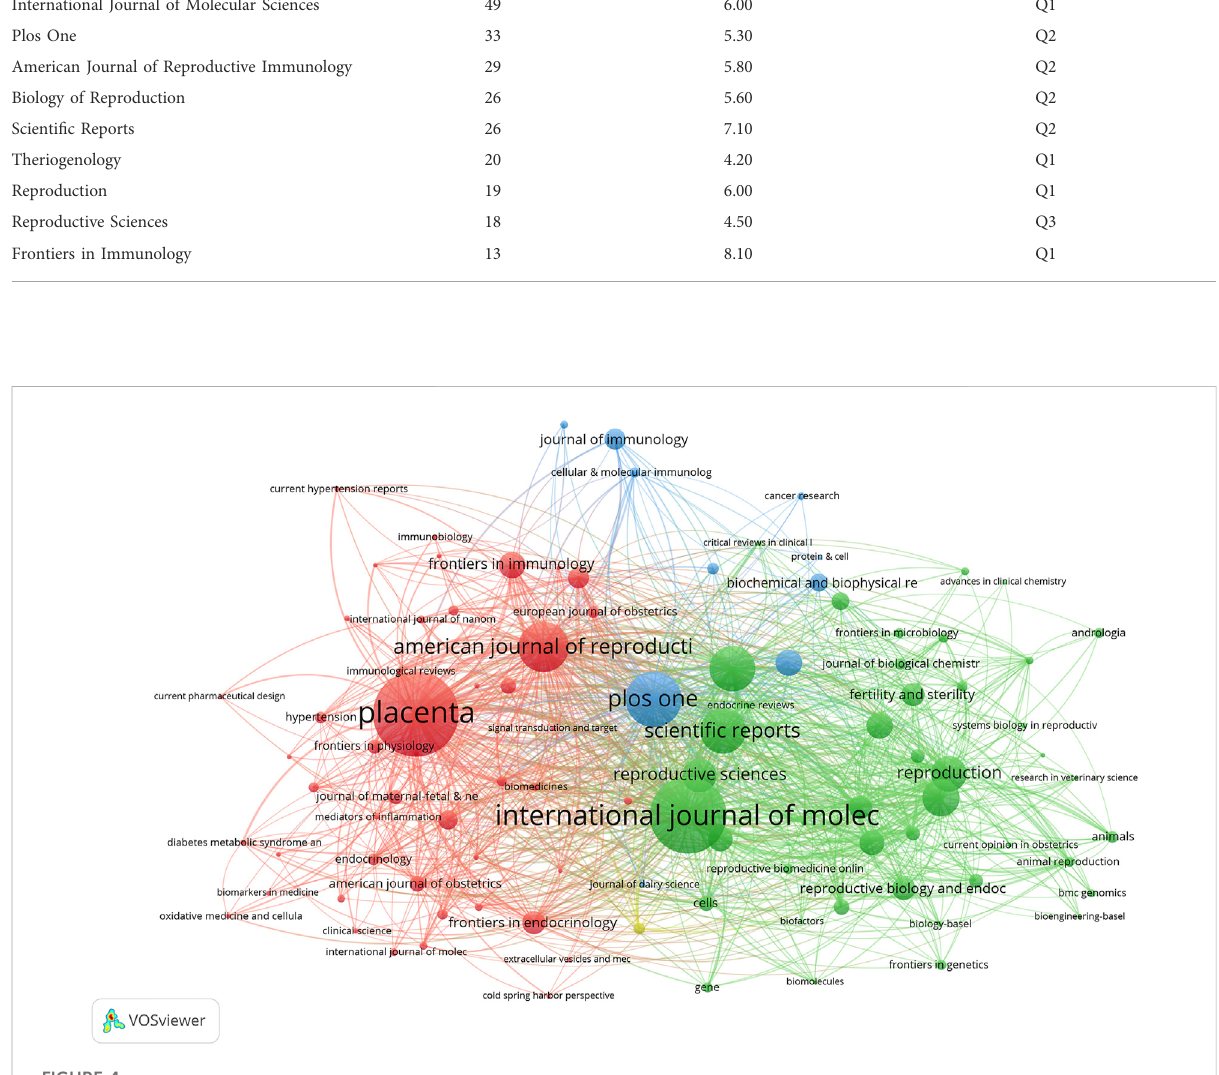
FIGURE 4 The distribution of journals publishing research on exosomes in